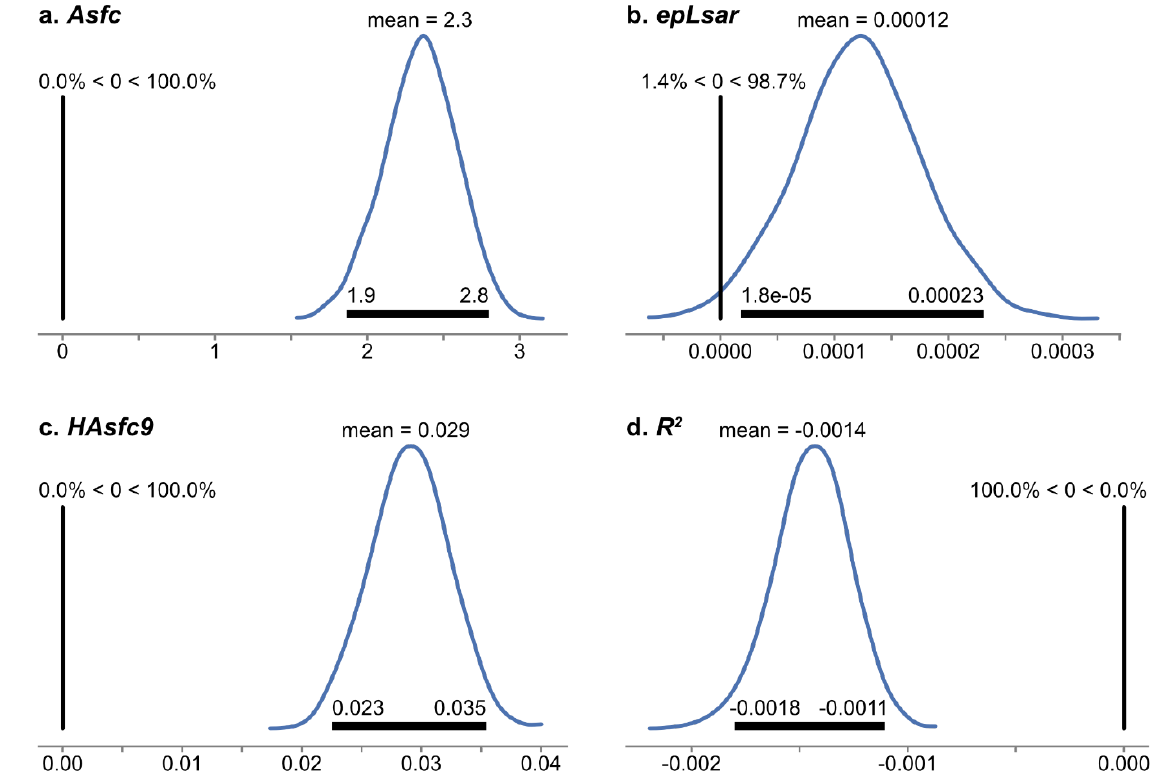
Fig. 4. Contrast plots of MountainsMap vs. Toothfrax from the three-factor model for the Scale- Sensitive Fractal Analysis (SSFA) parameters Asfc ( a ), epLsar ( b ), HAsfc9 ( c ) and R 2 ( d ) on the surfaces with < 5% non-measured points (NMP). The y-axis shows the probability density and the x-axis represents the difference in parameter between the two software packages. The black horizontal bar in each plot covers the 95% high density interval (HDI), with the associated values for its boundaries (2.5 and 97.5%). The black vertical line marks the 0-effect strength; the values above it indicate the estimated probabilities of the contrast being smaller or greater than 0. See text for details on surface